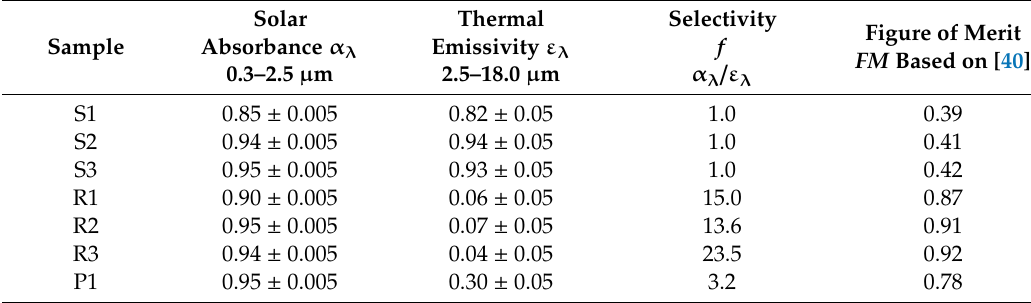
Figure 3. Spectral optical parameters of absorbers: ( a ) shortwave spectrum; ( b ) longwave spectrum. Table 2. Optical parameters and figure of merit of the tested solar absorbers.